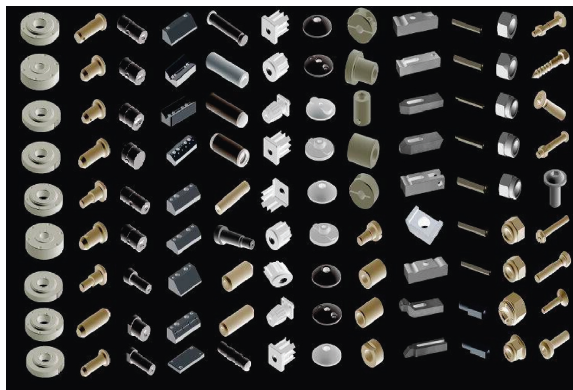
Figure 12: Example of CAD model